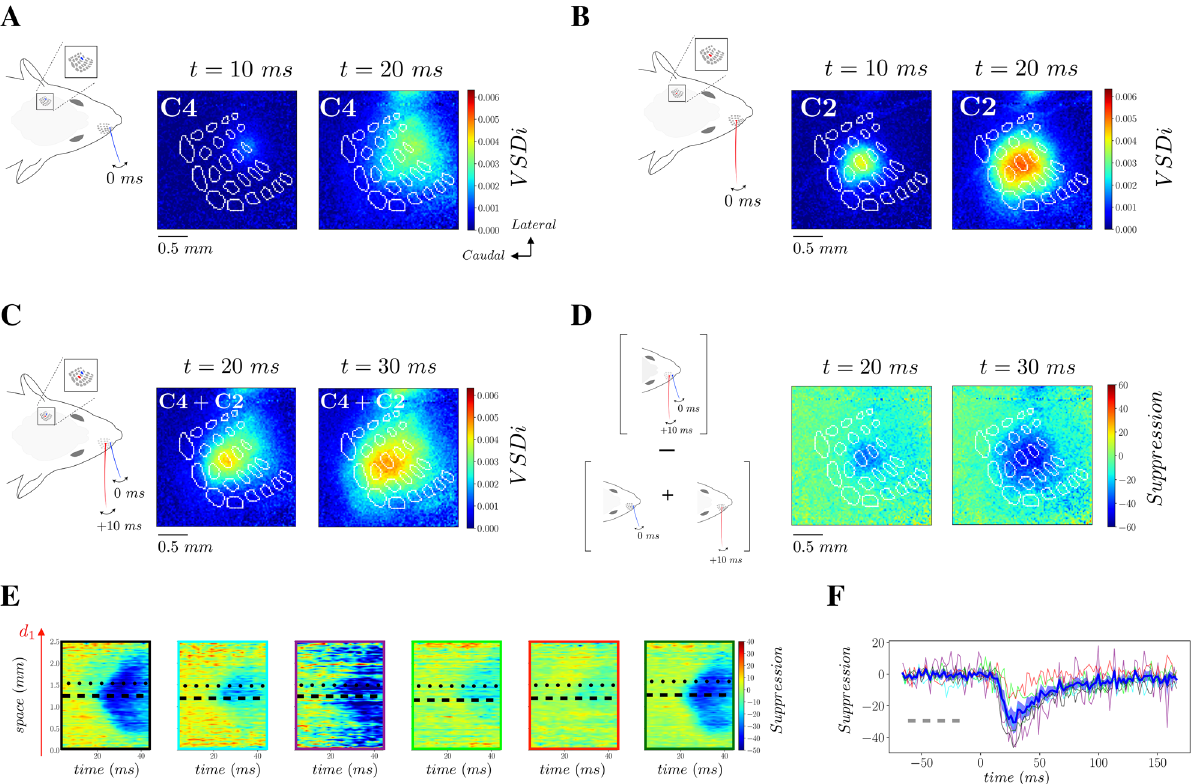
Figure 7. Suppressive interaction between propagating waves. (A) VSD activity in response to stimulation of the C4 whisker at time t = 0 ms ( B) VSD activity in response to stimulation of the C2 whisker at time t = 0 ms. ( C) VSD activity in response to the sequential stimulation of C4 and C2 whiskers with a delay of 10 ms ( D) Difference between data from experiment as in panel ( C) , and the linear prediction from panel ( A + B) (with proper + 10 ms time shift of data from C2 whisker stimulation), normalized by the maximum of activity in data of panel ( A) . ( E) Spatio-temporal representation of the suppressive waves for the 6 different mice. Dashed (dotted) black line indicates the location of C2 (C4) barrel. The different color contours stand for different mice. ( F) Time trace of the suppression at the C2 location (see dashed line in Panel E ) for the 6 mice (color coded according to the color of the frames in panel E ). The blue thick line is the mean across mice (the blue shadow indicating the standard